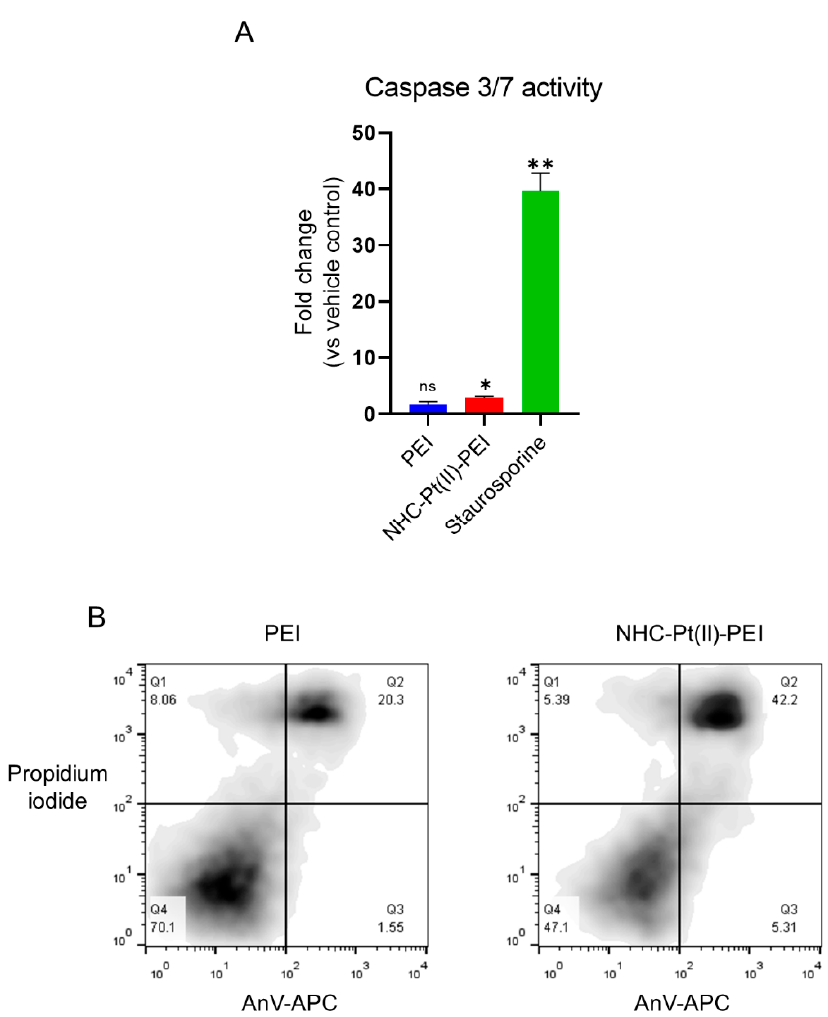
Figure 5. Absence of apoptotic markers on 24 h 2.5 µM NHC-Pt(II)-PEI and 2.5 µM PEI eq treated NCH421K spheroids. ( A ) Histograms showing fold change luminescence intensity compared to the corresponding vehicle control. Values represent the mean of at least n = 3 independent experiments ± one SEM. Statistics represent Student’s t-tests with a Welch’s correction vs. the corresponding vehicle reference. Distribution normality was confirmed using a Shapiro–Wilk test. ns = p > 0.05, * = p ≤ 0.05, ** = p ≤ 0.01. ( B ) Flow cytometry dot plots (FlowJo v10) of treated NCH421K cells stained with AnV-APC and PI. Viable cells = AnV − /PI − . Early apoptotic cells = AnV+/PI − . Late apoptotic/necrotic cells = AnV+/PI+. Early necrotic cells = AnV − /PI+.